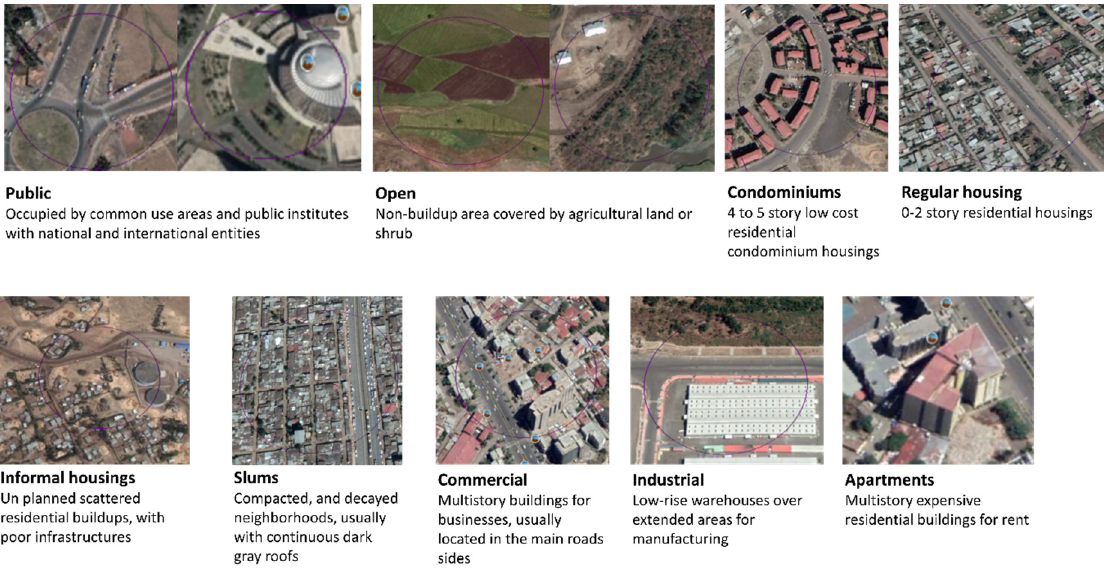
Figure 3. The land use classification categories, based on the land parcels falling within the sample point circles.